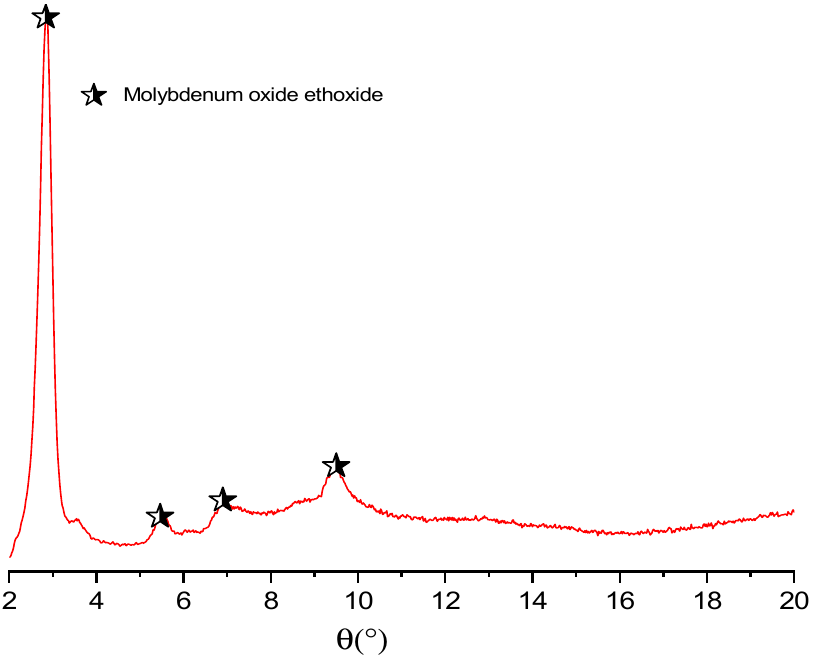
Figure 4. XRPD of the obtained molybdenum octahedral cluster complex Mo OHCs.